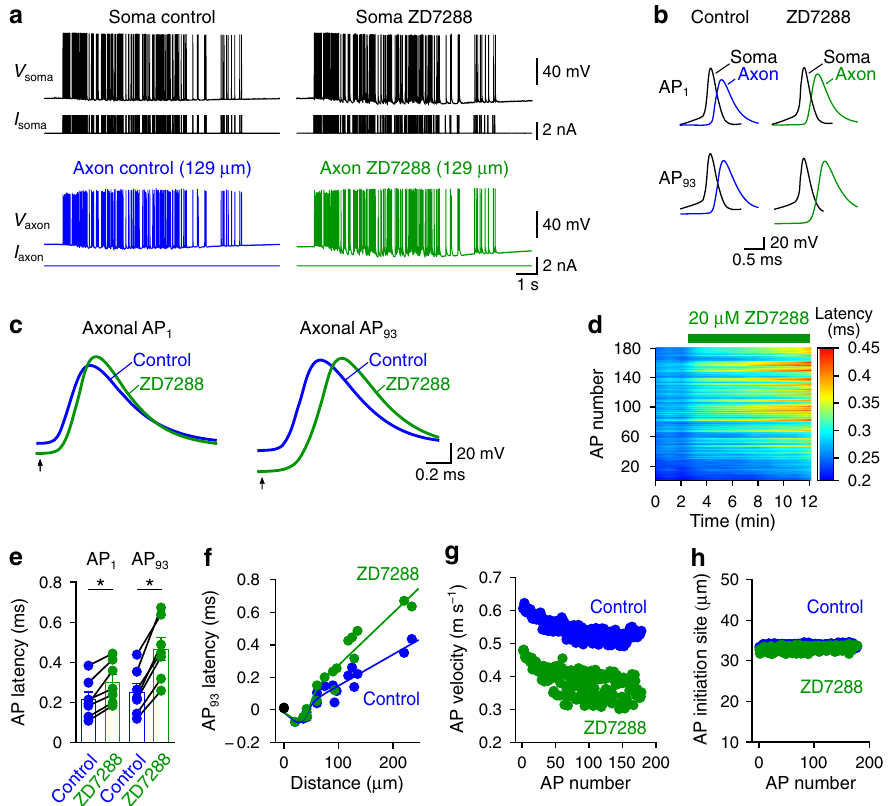
Fig. 3 HCN channels speed up the propagation of a physiologically relevant AP pattern in PV + -BC axons. a Simultaneous soma – axon recording of APs elicited by stimulating the soma of a PV + -BC with a physiologically relevant AP pattern in control (left) and 20 µ M ZD7288 (right). b First (top, AP 1 ) and 93rd (bottom, AP 93 ) APs in the train in control and ZD7288 plotted on an expanded time scale. c Superimposition of axonal APs in control and ZD7288 to show that blocking HCN channels delayed the arrival of APs at the axonal recording site. Only the fi rst and 93rd APs in the train are shown. To compare spike timing, axonal APs were aligned by using the time point (arrows) at which the corresponding somatic AP reached the half-maximal peak amplitude in the rising phase as the temporal reference. Black traces in a – c , somatic voltage and current; blue traces, axonal voltage and current in control; green traces, axonal voltage and current in ZD7288. d Heat map plotting the latency between somatic and corresponding axonal APs for every AP in the train against experimental time. Data in a – d are from the same experiment. e Summary graph showing that 20 µ M ZD7288 increased the soma – axon AP latency in 7 distal (>100 µ m) recordings. For clarity, only the fi rst and 93rd AP latencies are shown. Data points from the same recording are connected by lines. * indicates P = 0.02 ( n = 7 soma – axon recordings, two-sided Wilcoxon signed rank test). Error bars in bar graphs represent ± SEM. f Latency between the 93rd somatic AP in the train and corresponding axonal AP plotted against distance from the soma ( n = 16 soma – axon recordings). Data were fi t with a bilinear function (continuous lines). g , h Axonal propagation velocity ( g ) and initiation site ( h ) of every AP in the train in control and 20 µ M ZD7288. Blue circles and lines in e – h , from data in control; green circles and lines, from data in 20 µ M ZD7288. Source data are provided as a Source data fi